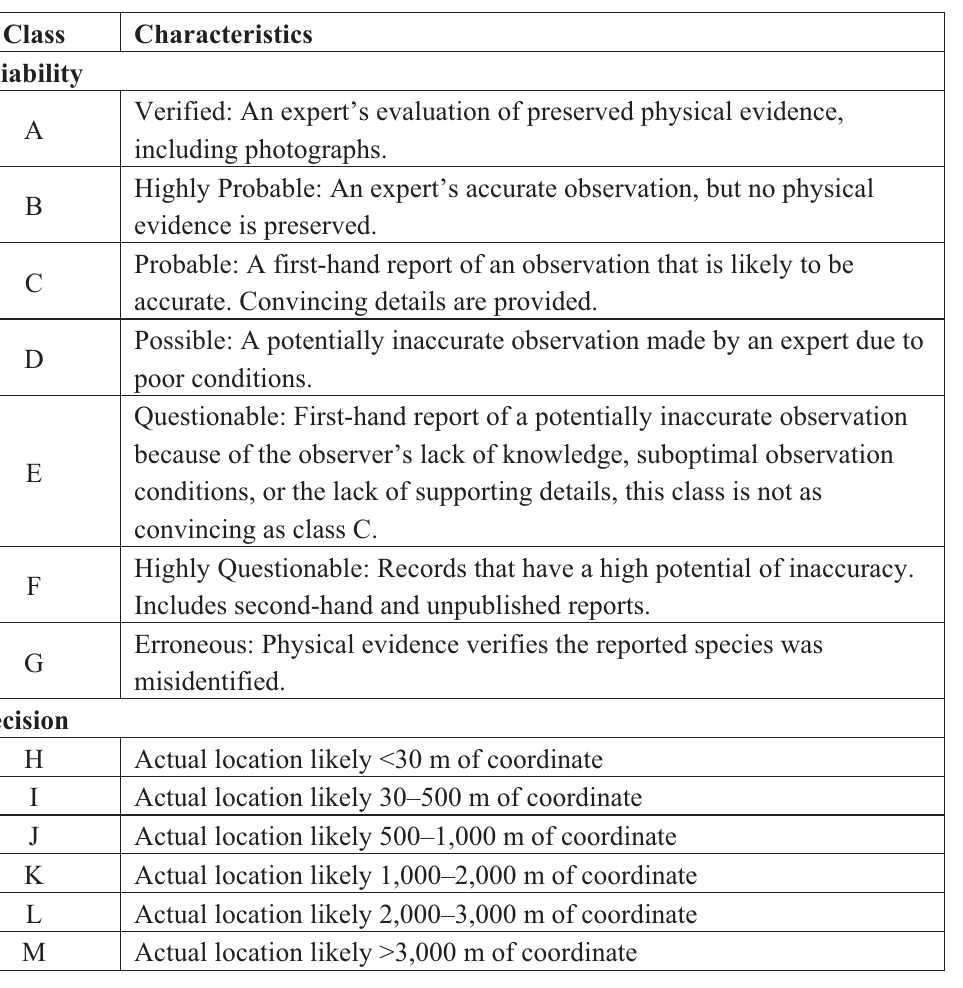
Table 1. Classes for evaluating the reliability and precision of occurrence records for the white-nosed coati ( Nasua narica ) in Arizona and New Mexico. Reliability classes were adapted from Frey